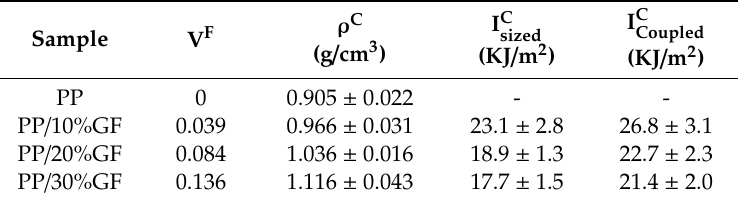
Table 4. Specific impact resilience of Charpy un-notched PLA / BKSP composites and uncoupled and coupled polypropylene (PP) / glass fibers (GF) composites against reinforcement content.